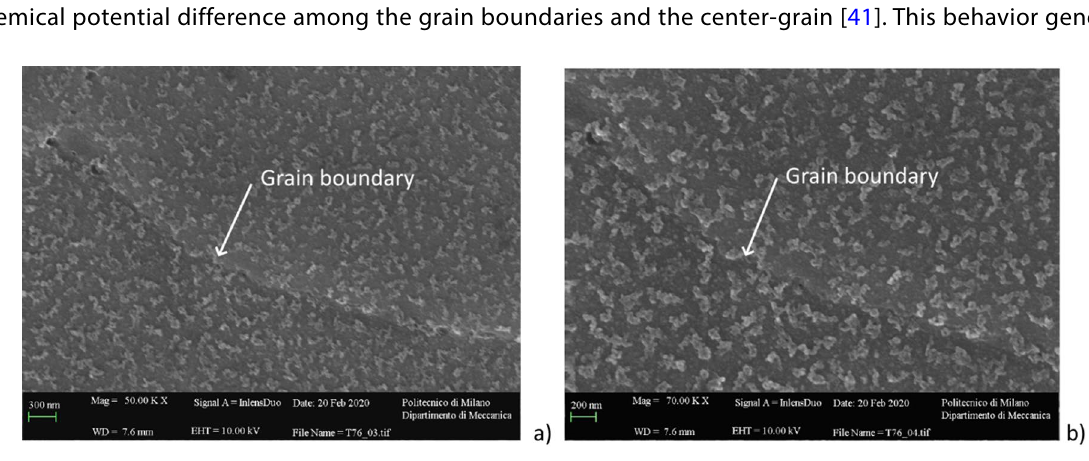
Fig. 13 Precipitate distribution at the grain boundaries—T76 temper. b is the magnification of a